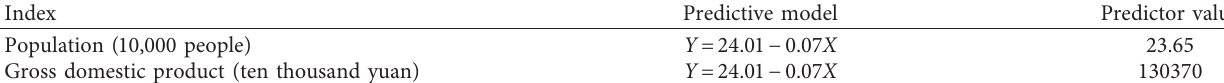
Table 5: Socioeconomic index prediction models and index values.